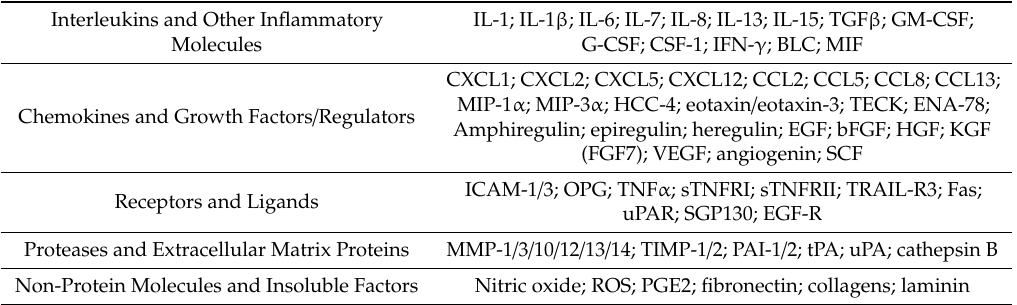
Table 1. The senescence-associated secretory phenotype (SASP) factors (based on [24,34]). Interleukins and Other Inflammatory